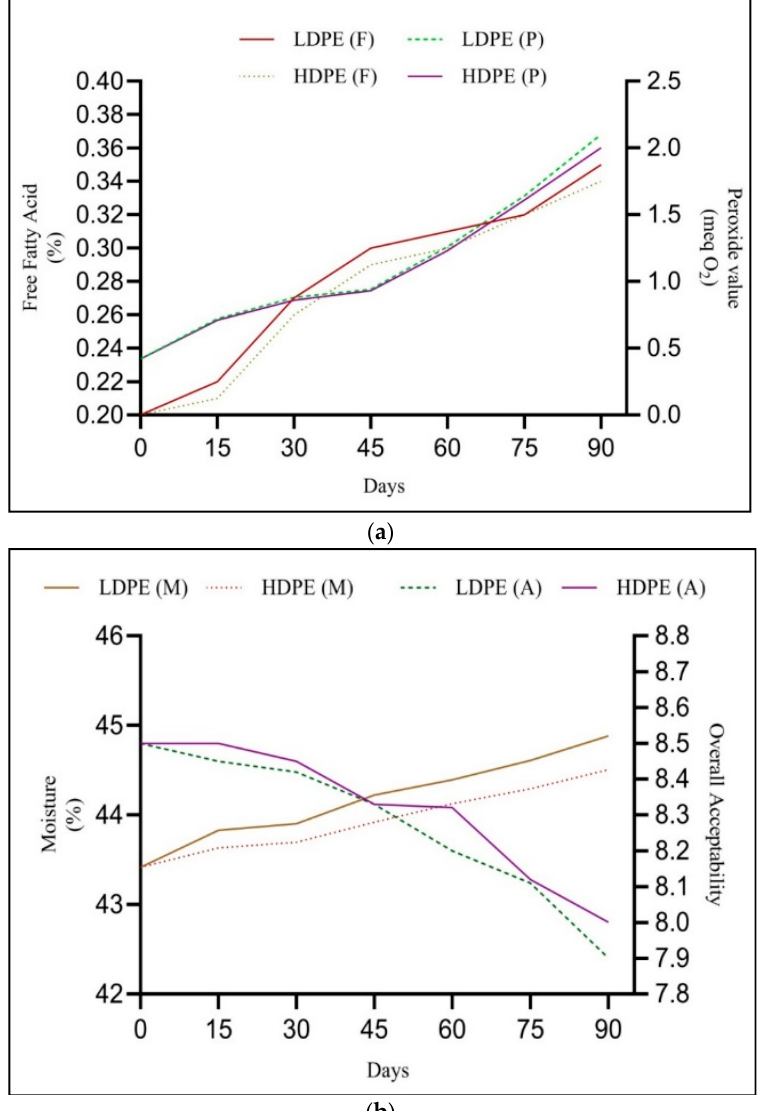
Figure 6. Storage studies: ( a ) Effect of packaging material on the free fatty acid content and peroxide